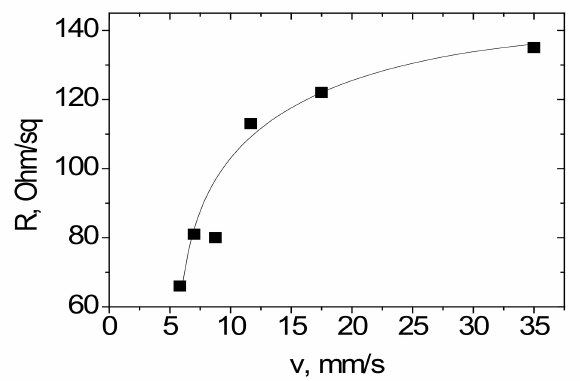
Figure 7. Dependence of the resistance of the MOG film on the speed of the laser beam.